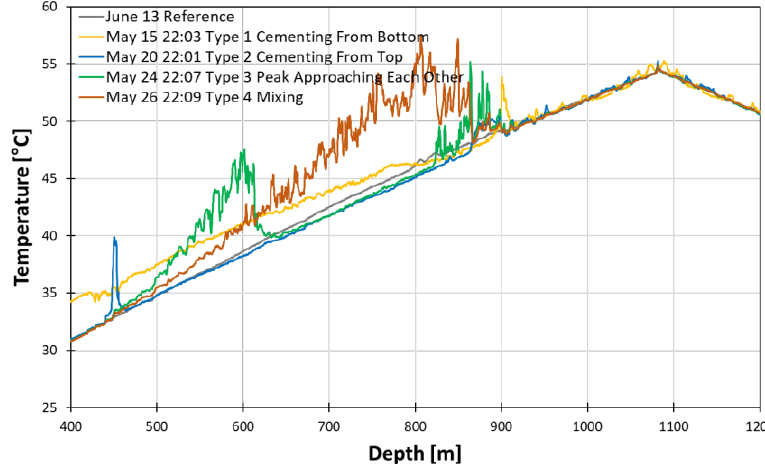
Figure 18. Temperature profiles during the curing process in detail.